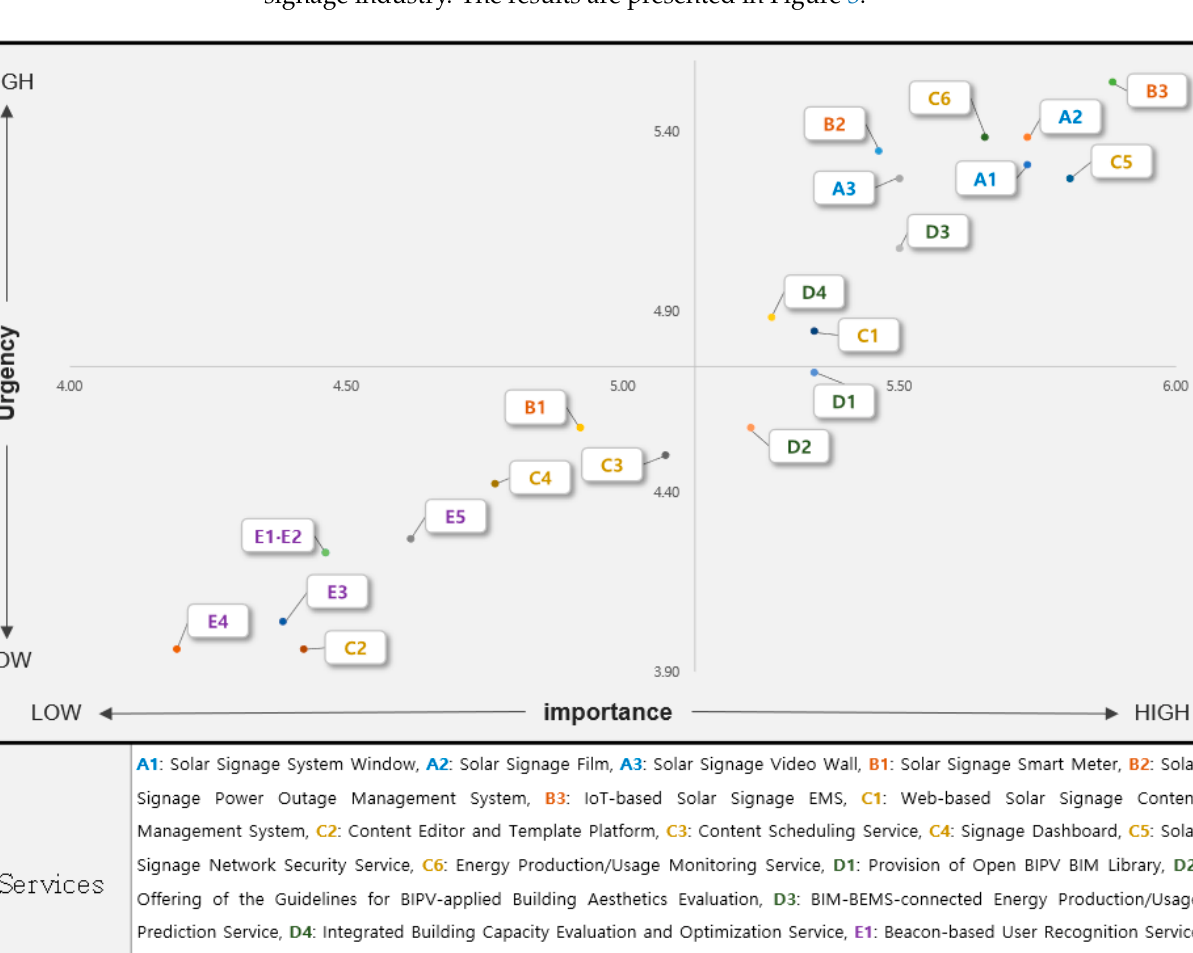
Figure 3. Analysis results of the derived service significance-timeliness.